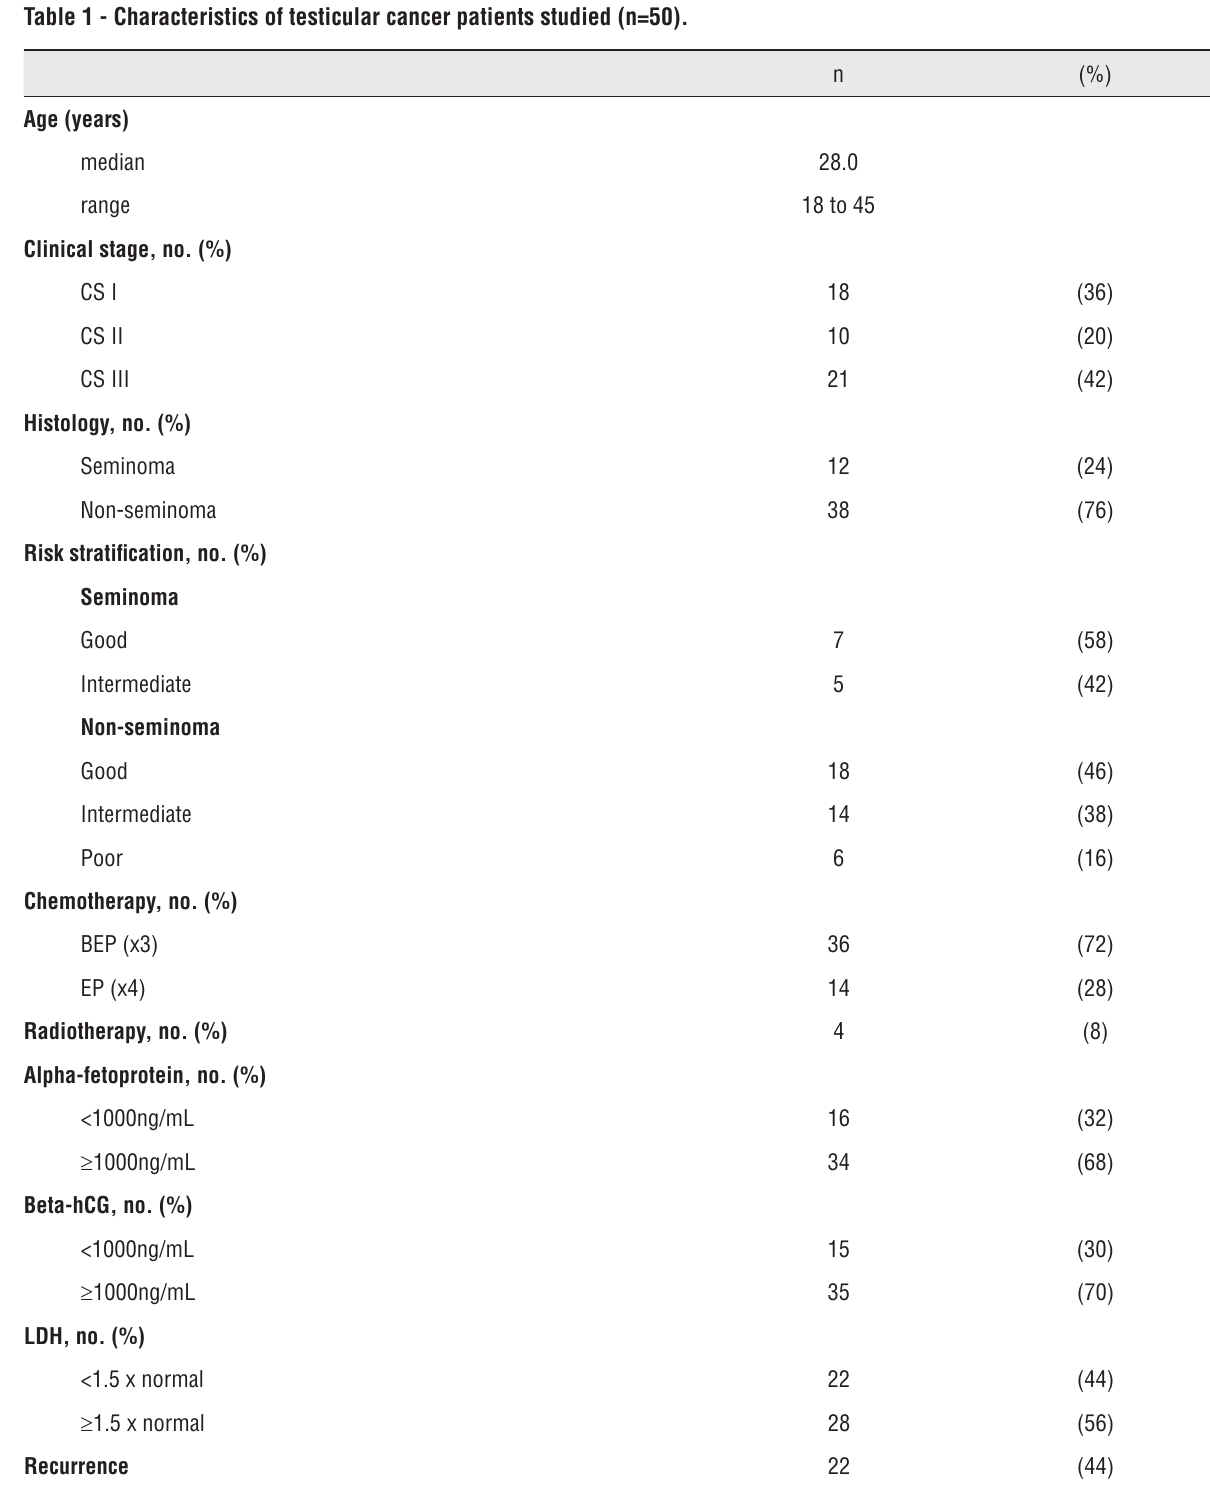
Table 1 - Characteristics of testicular cancer patients studied